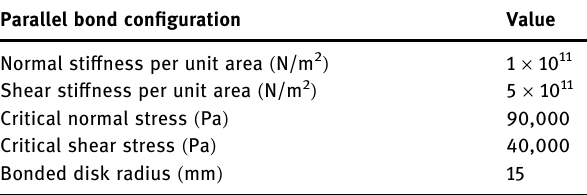
Table 2: Bonding